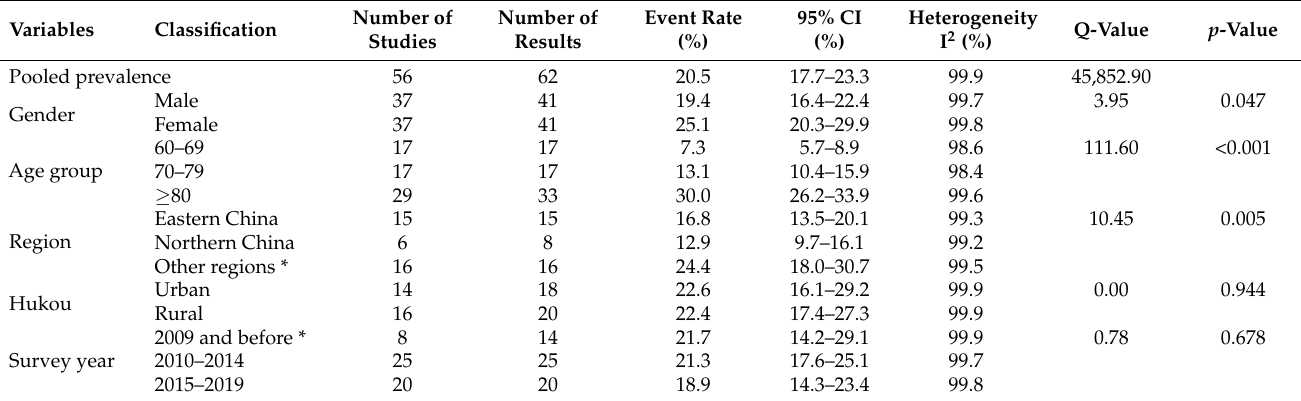
Table 3. Pooled prevalence of BADL disabilities and subgroup analyses.